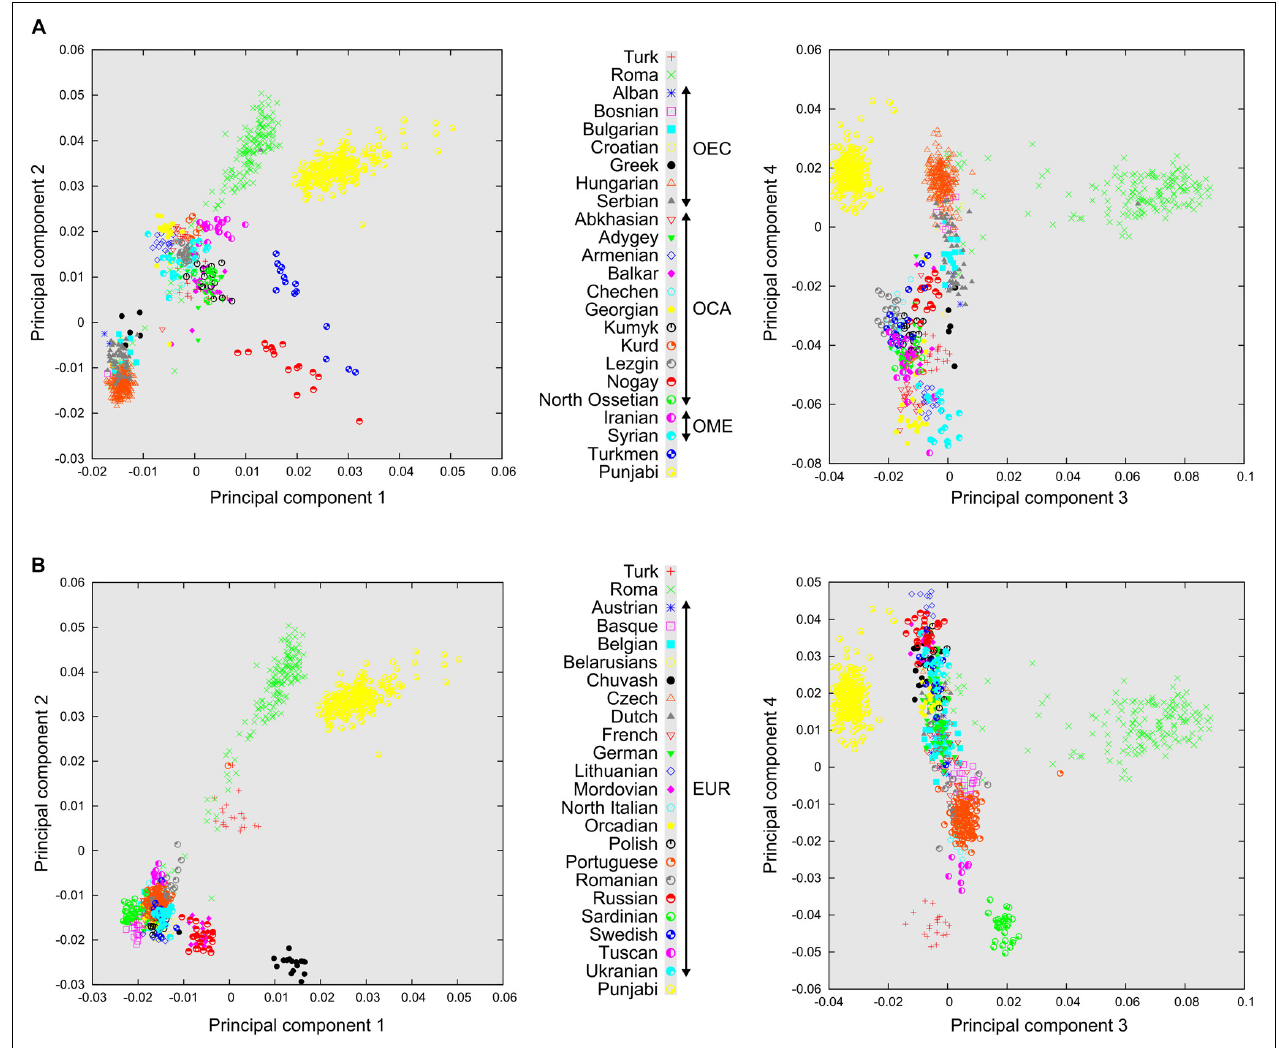
FIGURE 2 | Relationship of Turks and Roma to distinct Eurasian Populations according to PCA. PCA results plotted on four principal components. Each symbol represents one individual. (A) Relationship of Turks to formerly Ottoman occupied populations in East-Central European populations (OEC), Caucasus region populations (OCA), Middle Eastern populations (OME), and also Romani people. (B) Relationship of Turks and European populations not affected by the Ottoman conquest (EUR). Note that these PCA graphs are the results of the same PCA